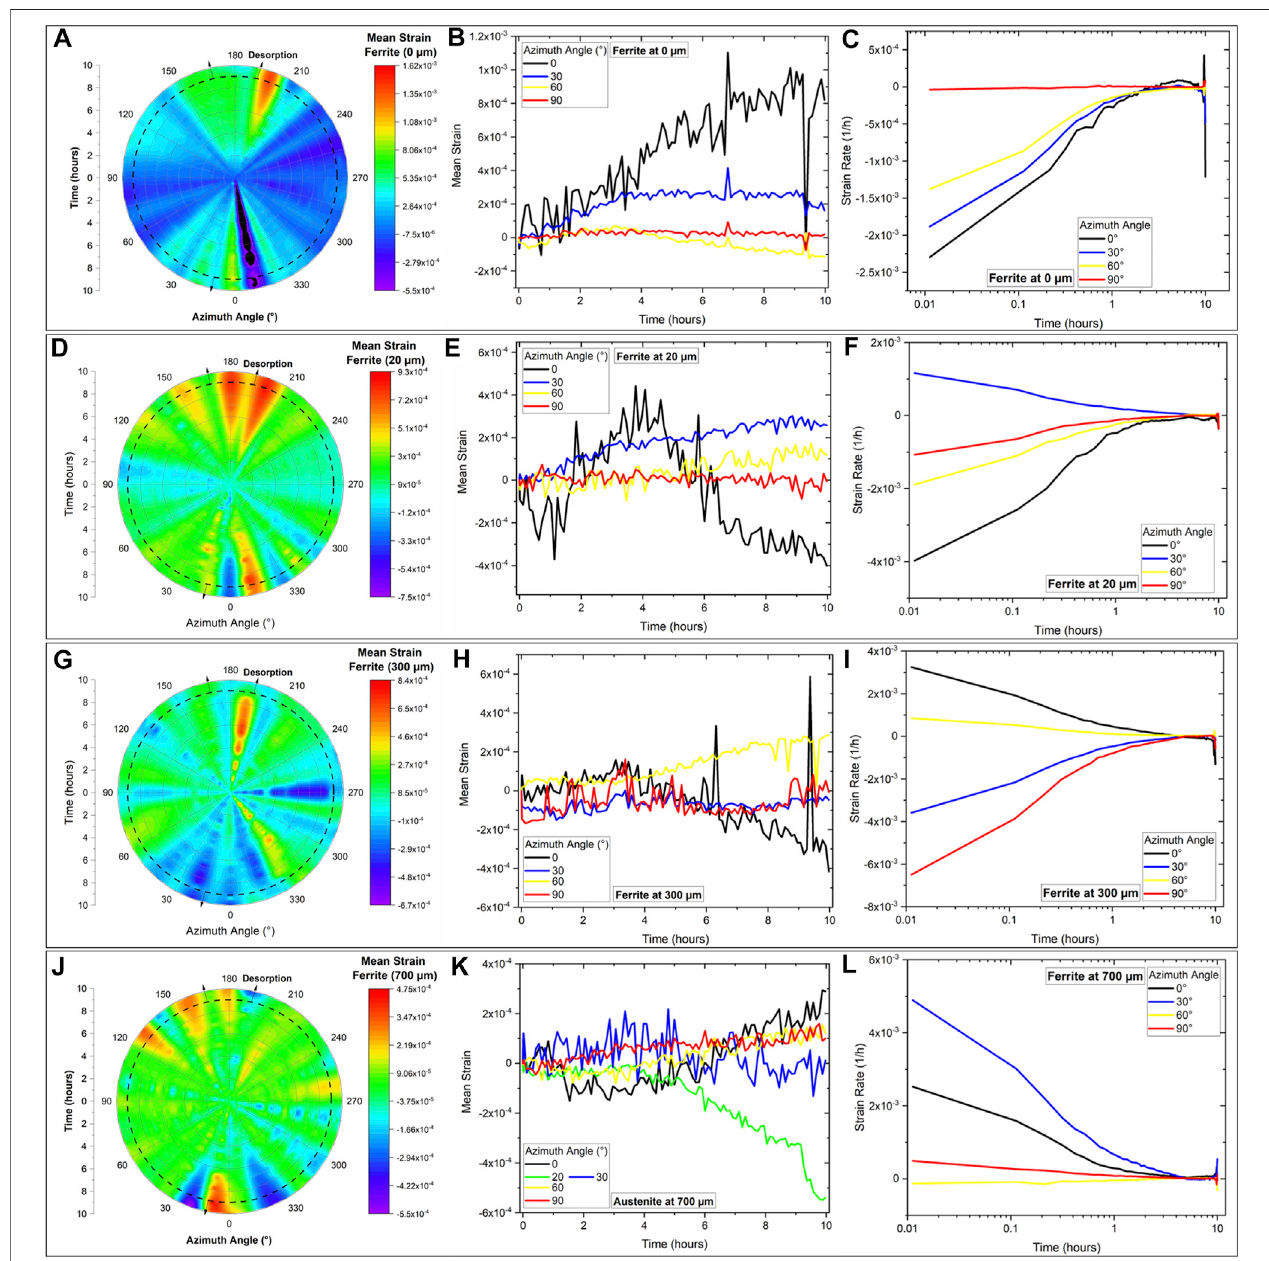
FIGURE 8 | 3-D polar strain plots of the ferrite phase showing the lattice strain development as a function of time of hydrogen charging at different depth regions: (A – C) at the surface, (D – F) at 20 µm, (G – I) 300 µm, and (J – L) 700 µm below the surface. The radial axis shows the time (the centre is t (cid:1) 0), and the angular axis is the azimuth angle. The pro fi les in (B,E,H,K) show the strain evolution over selected azimuth angles. Note that the data along 350 ° is less reliable due to the beam-stop mount, which was masked for data integration but might affect the data.